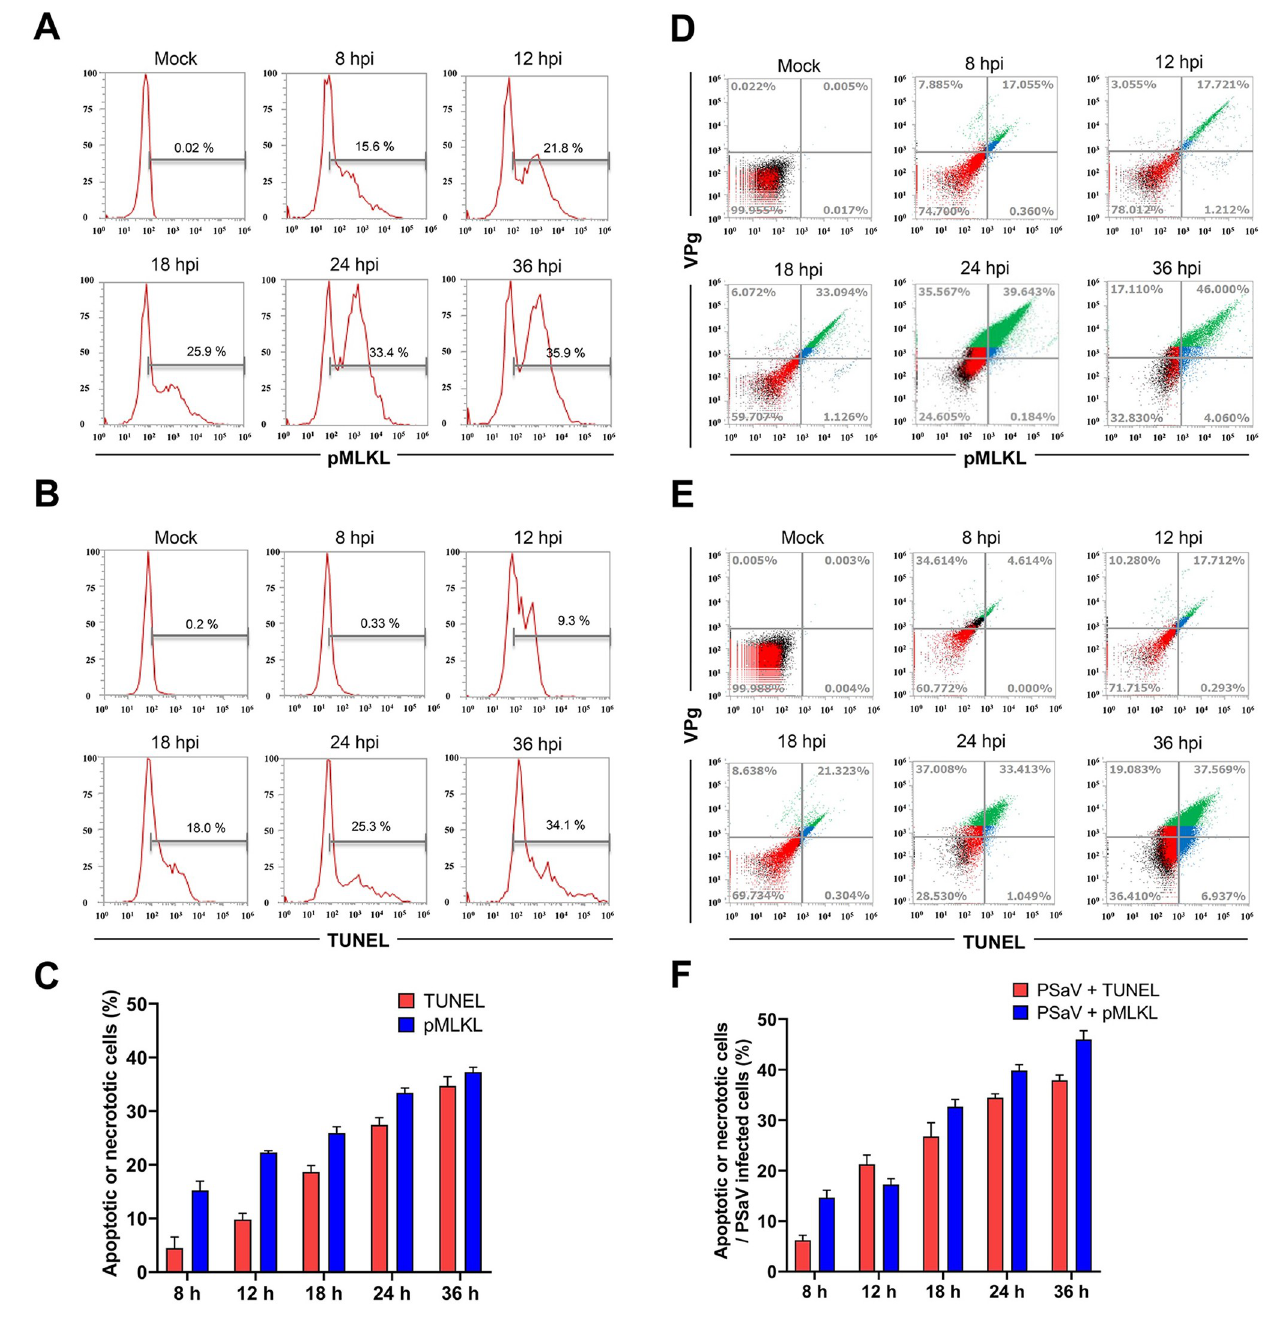
Fig 2. Dynamics of PSaV-induced necroptosis and apoptosis. (A, B) LLC-PK cells either infected with PSaV Cowden strain (MOI = 1 TCID 50 ) or left mock- infected in the presence of 200 μ M GCDCA were harvested at the indicated time points and analyzed using flow cytometry to quantify the number of necroptotic cells using pMLKL antibody (A) or apoptotic cells using TUNEL staining (B). (C) The graphical representation of the necroptotic and apoptotic cell populations in panels A and B. (D, E) The LLC-PK cells harvested in the above condition were co-labeled for the PSaV VPg antigen (using VPg antibody) and either TUNEL or pMLKL antibody and analyzed by flow cytometry to detect PSaV-positive necroptotic (D) or apoptotic (E) cells. (F) The graphical representation of the PSaV VPg-positive necroptotic and PSaV VPg-positive apoptotic cell populations in panels D and E. Data are shown as the percentage of necrotic or apoptotic cells in PSaV infected cells. The data in panels C and F represent the means ± standard error from two independent experiments.